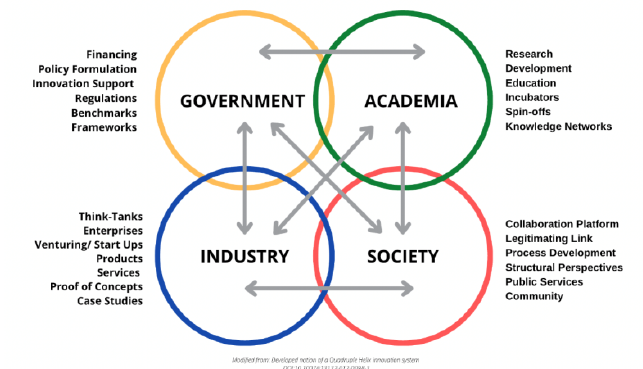
Recommendations